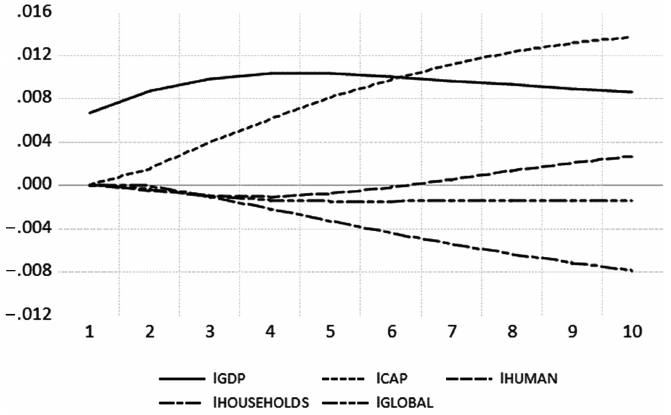
Figure 7. Response of RGDP to innovation (with lFIRMS) (source: authors’